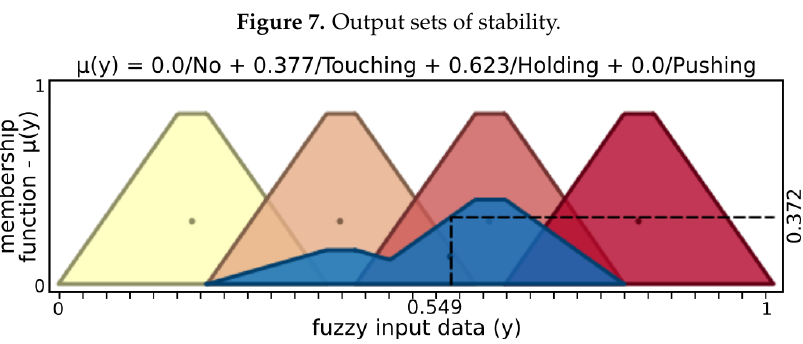
Figure 7. Output sets of stability.